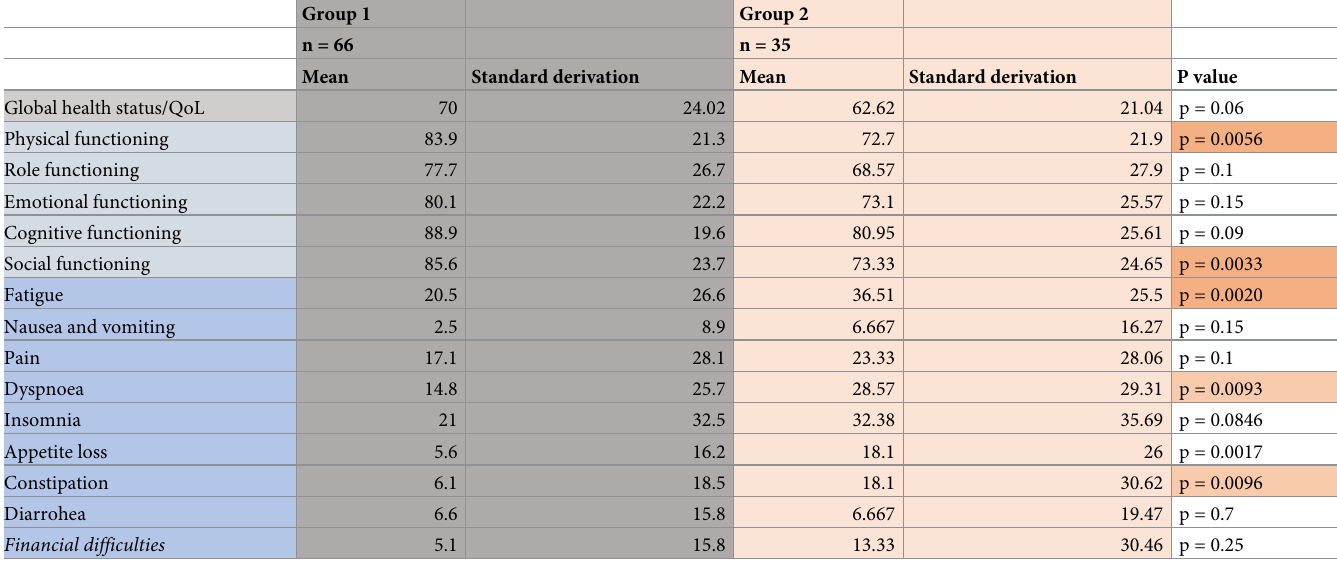
Table 6. EORTC quality of life questionnaire—C30 of both our groups. Group 1 Group 2 n = 66